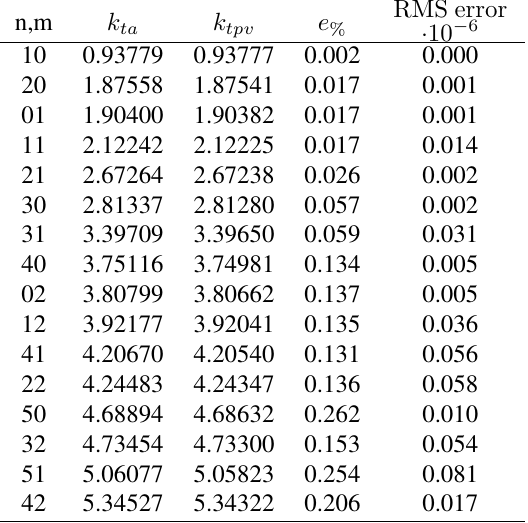
Table 1: Validation test for a rectangular waveguide.